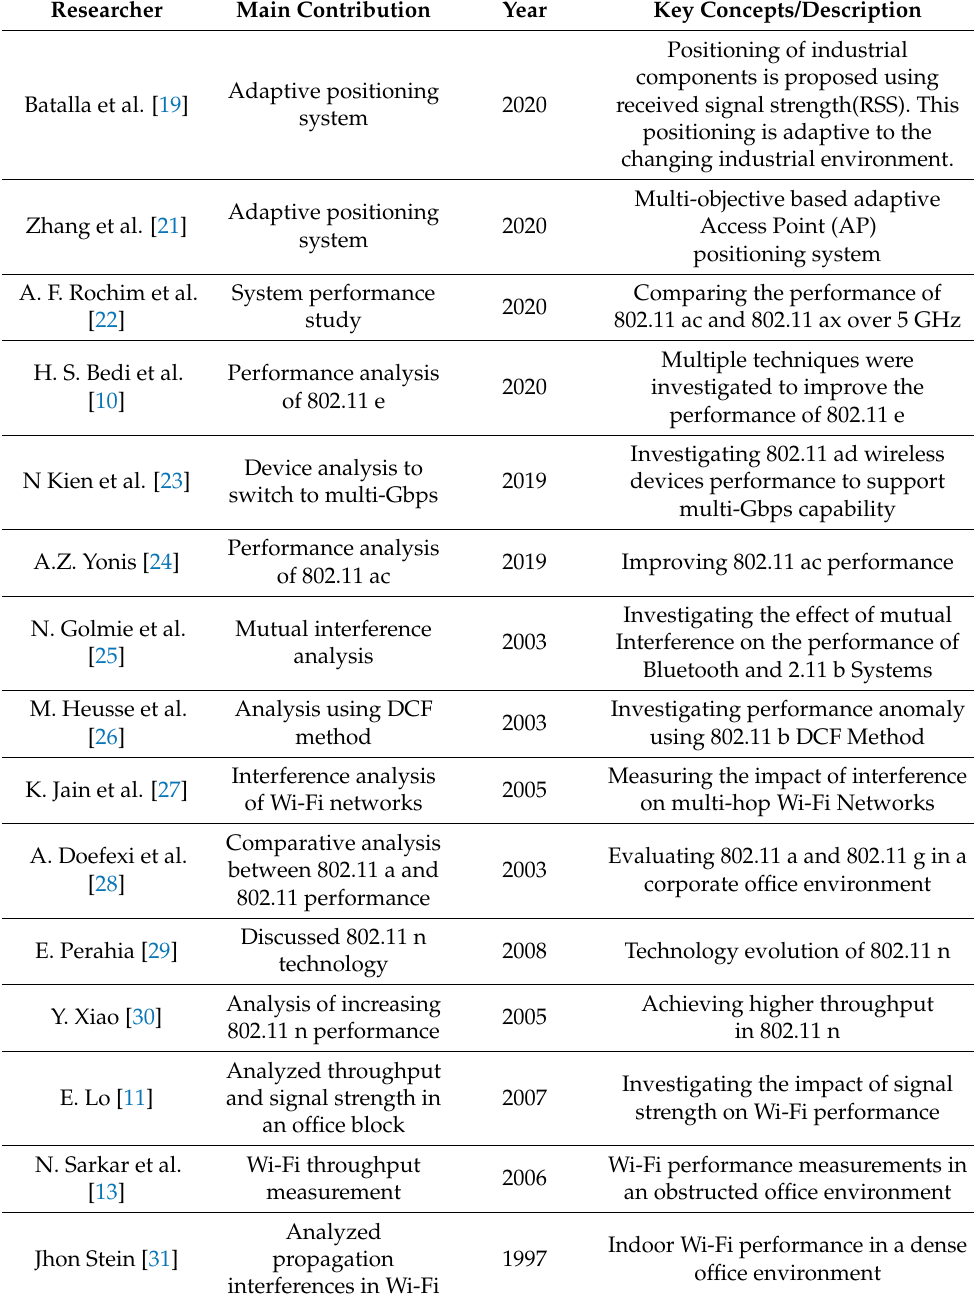
Table 2. Summary of related